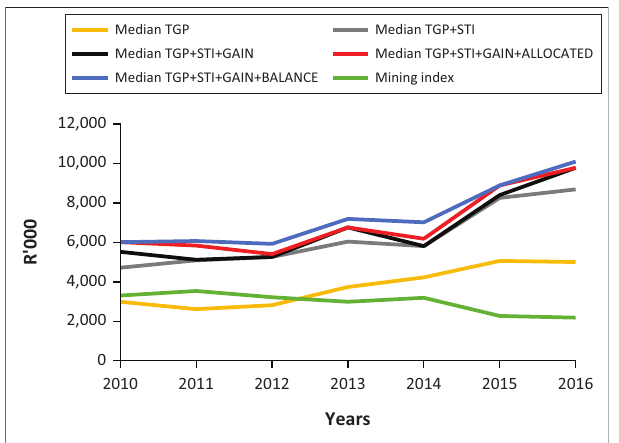
FIGURE 2: Chief executive officer’s remuneration: Median